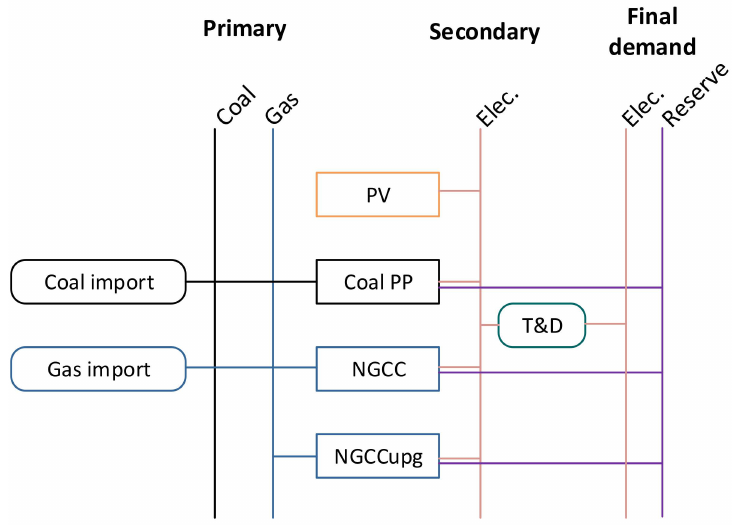
Figure 2. Reference Energy System (RES) of the case study.